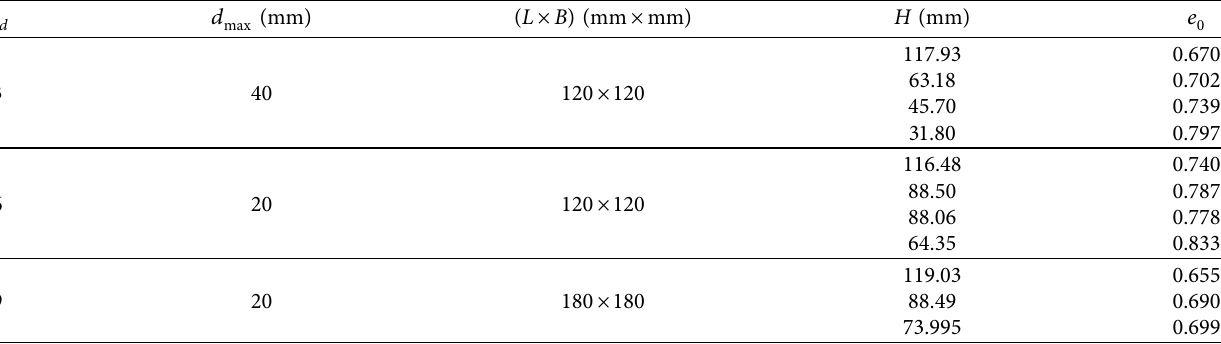
Table 4: Specimen characteristics.